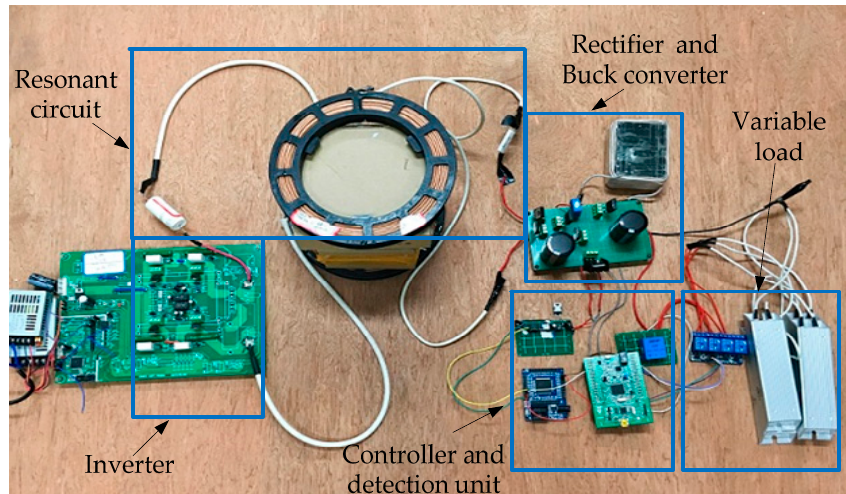
Figure 10. The experimental setup.